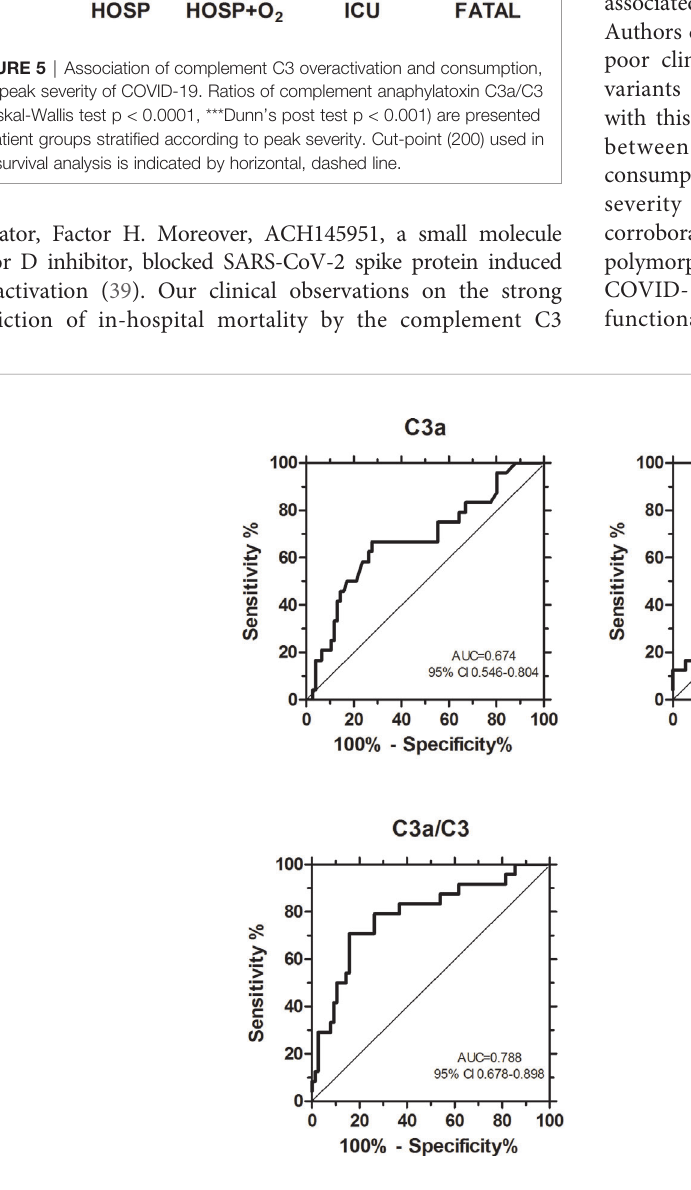
FIGURE 6 | Receiver-operator characteristics (ROC) analysis to evaluate the relationship between complement markers and mortality, and to obtain optimum cut- points differentiating survivor and non-survivor patients. ROC curves with C-statistics and 95% con fi dence interval are